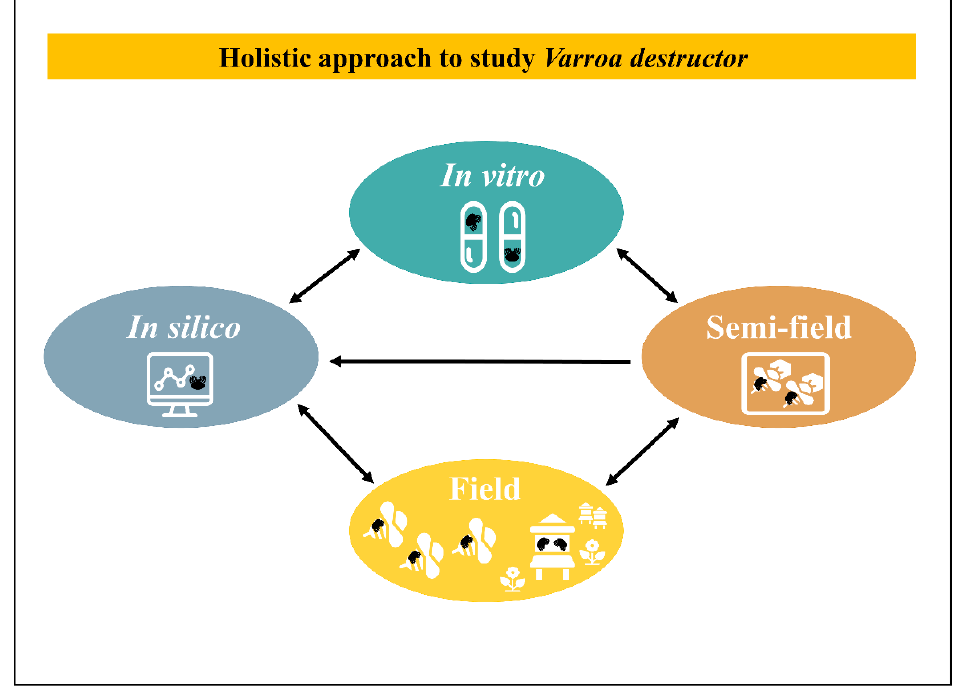
Figure 3. Holistic approach to study V. destructor . This process includes in silico , in vitro , semi-field, field tests and back to modelling with new enriched data. Each arrow indicates enriched exchanges between scales.